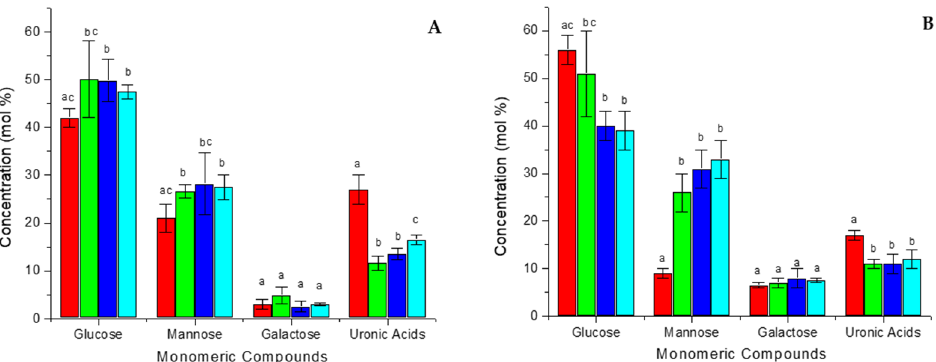
Figure 2. Monosaccharide composition of polysaccharides isolated from the different Aloe vera gel samples: ILF (red), DAG60 (green), DAG80 (blue), DAG100 (cyan) ( A ). AILF (red), AAG60 (green), AAG80 (blue), AAG100 (cyan) ( B ). Error bars indicate SD. Significant differences for different samples for each compound are indicated by different letters. (The exact values can be found in Table S2 of the Supplementary Materials).